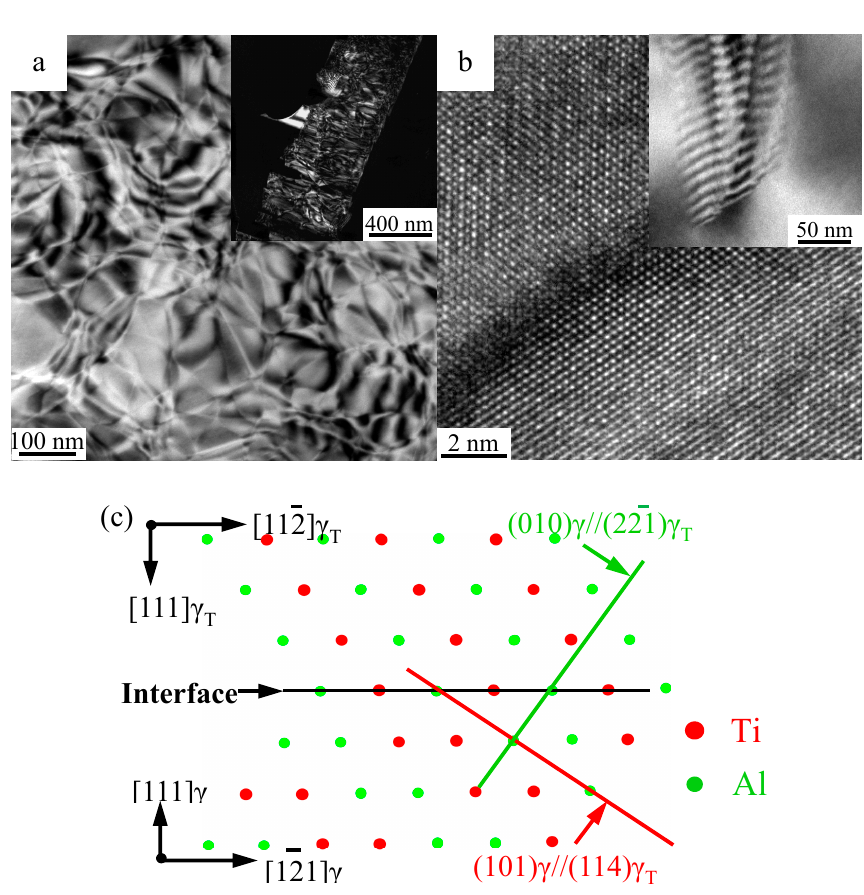
Figure 6. ( a , b ) TEM and HRTEM images of the γ p phase with anti-phase boundaries (APBs) in the γ s phase; ( c ) supposed schematic models of the 120 ◦ order fault domain with BD = [101] γ //[110] γ T